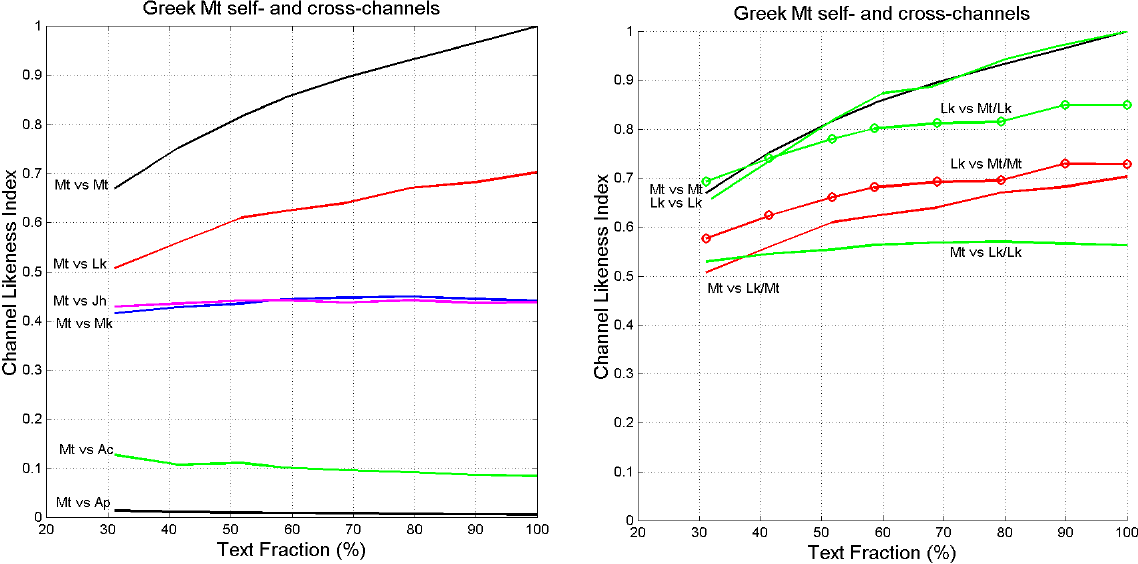
Figure 16. I L vs. text fraction considered in the Monte Carlo simulations in Greek. ( Left panel ): Matthew self-and cross-channels; color key in left panel : red refers to cross-channel Mt vs. Lk, blue to Mt vs. Mk, magenta to Mt vs. Jh, green to Mt vs. Ac, black to Mt vs. Ap; g 1 ( y ) refers to Mt self-channel. ( Right panel ): Matthew and Luke self- and cross-channels; color key in right panel : red lines refer to cross-channel compared to Mt self-channel; green lines refer to cross-channels compared to Lk self-channel. g 1 ( y ) refers to Mt self-channel (indicated by/Mt) or to Lk self-channel (indicated by/Lk).